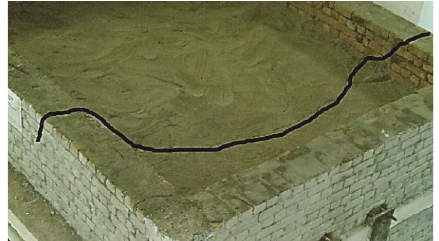
Figure 12: Line shows the crack appeared in the slab.